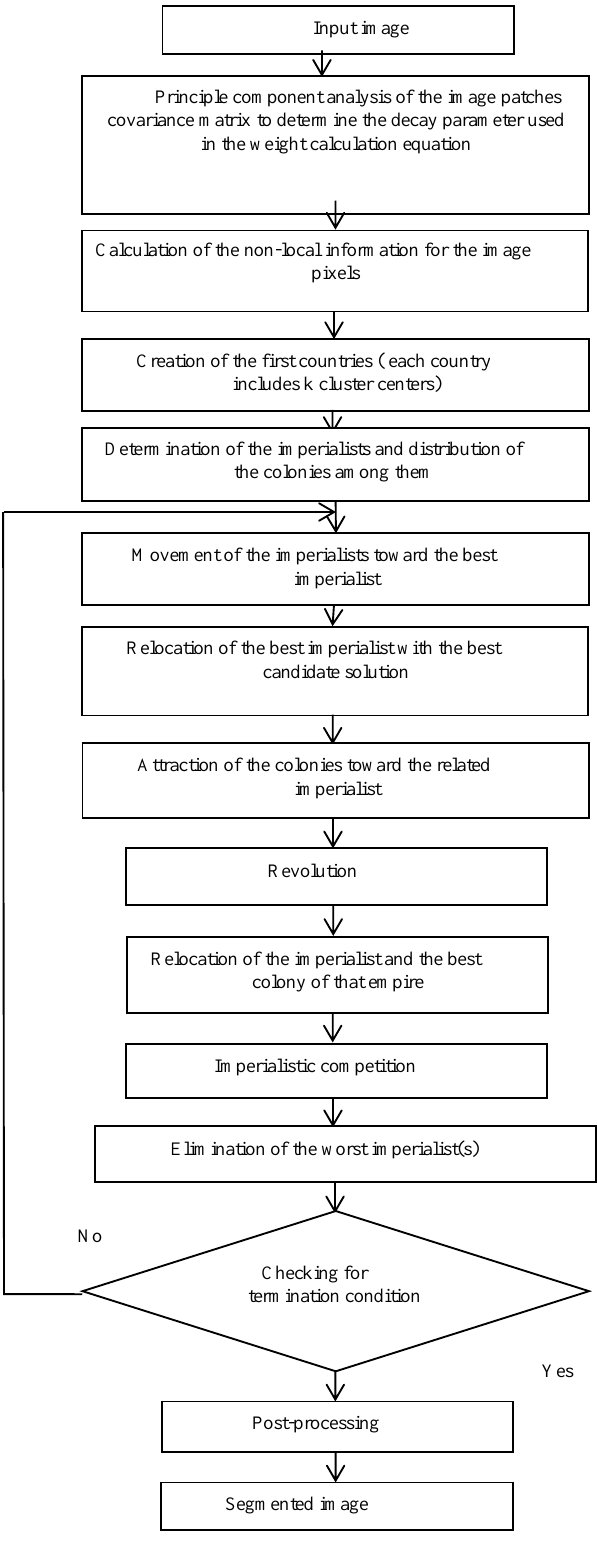
Figure 2. Flowchart of the NLICA